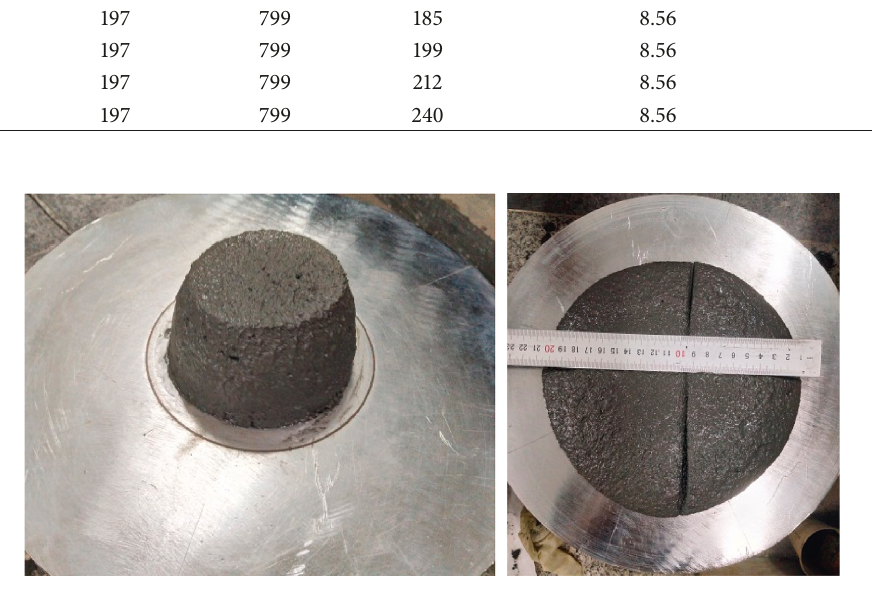
Figure 3: Fluidity test of graphite